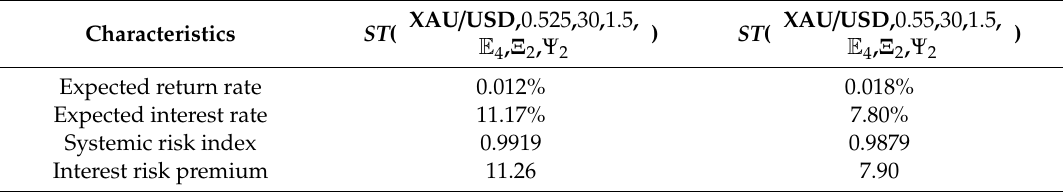
Table 9. Juxtaposition of global characteristics of ST systems applied for XAU/USD market.